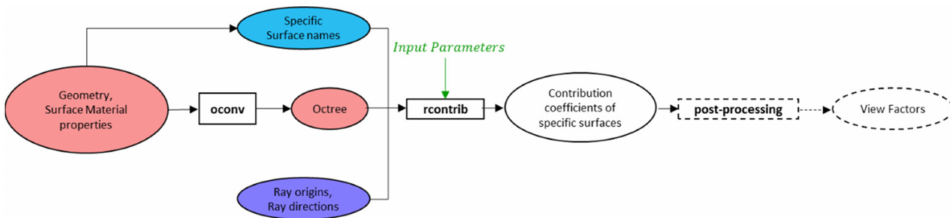
Figure 5. The proposed workflow for calculating view factors with RADIANCE. RADIANCE programs are identified through rectangles, and inputs and outputs are denoted through ellipses. The dotted figures represent a script and output that is external to RADIANCE. The colors used in this figure are complimentary to the ones used in Figure 3c.